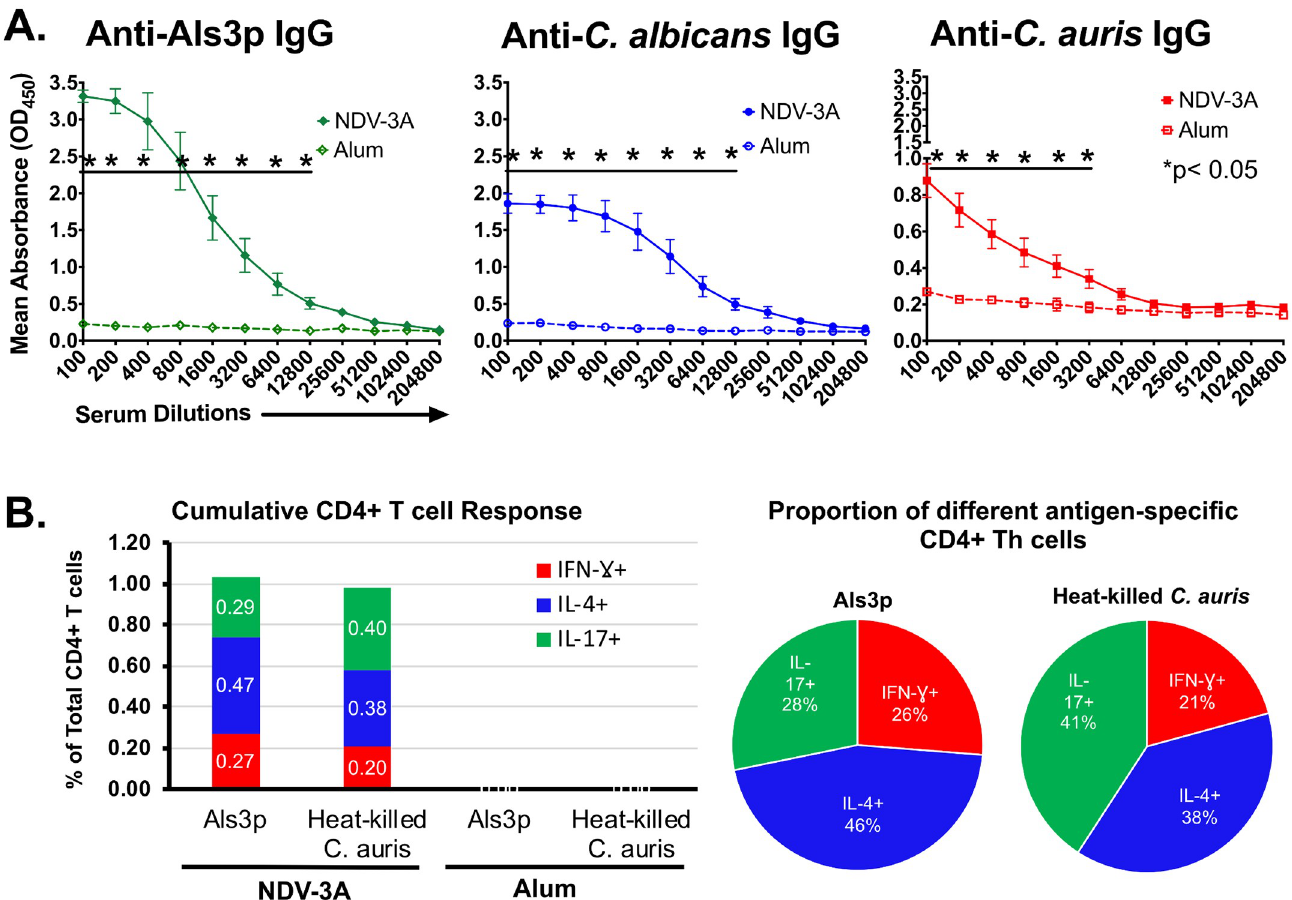
Fig 3. Evaluation of C . auris cross-reactive antibodies and CD4+ T cells in NDV-3A-vaccinated mice. (A) Sera samples from NDV-3A-vaccinated mice were used to detect anti-Als3p antibodies in antigen ELISA and anti- C . albicans and anti- C . auris IgG antibodies by using cell-based ELISA. Serially diluted serum samples were incubated in Als3p-coated 96-well plate or C . albicans , or C . auris cells as antigens. The OD450 values for each mouse were plotted against the serum dilution and mean endpoint titers were determined against each antigen by two-way ANOVA between NDV-3A and alum control for each dilution. (B) The splenocytes from individual NDV-3A- or alum-vaccinated mice (n = 4) were stimulated for 5 days with no antigen, Als3p or heat-killed C . auris as recall antigens. After 3 hours stimulation with PMA/ionomycin in presence of protein transport inhibitor, the cells were stained for CD3, CD4, IFN- γ , IL-4 and IL-17. The % of Th1 (IFN- γ +), Th2 (IL-4+) and Th17 (IL-17+) CD4+ T cells were reported after subtracting the no antigen stimulation values. Data is reported as mean of total CD4+ T cell responses (Left panel). Pie chart on the right shows proportions of antigen specific T helper cell